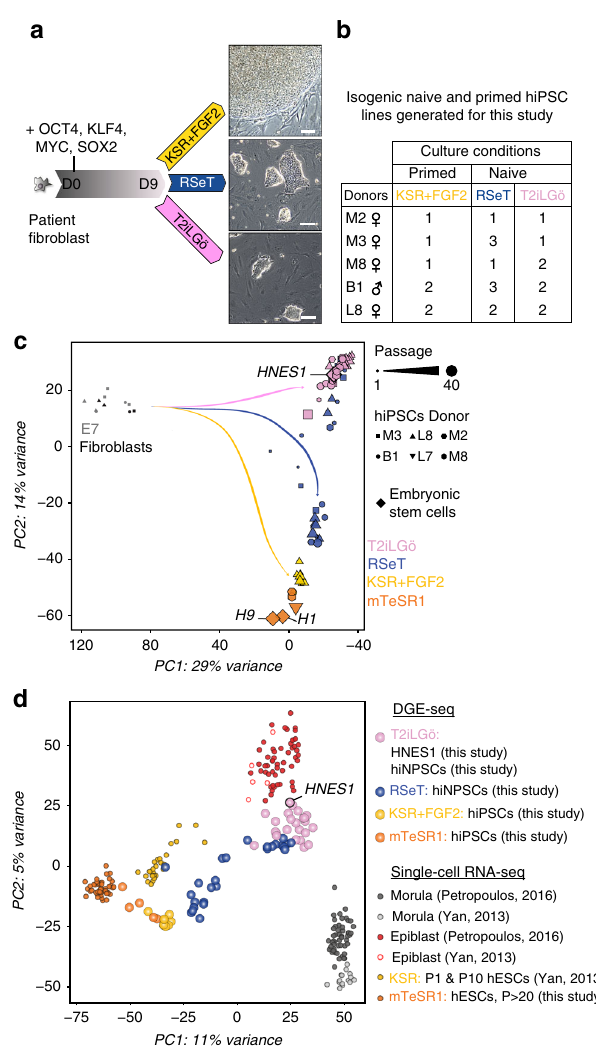
Fig. 1 Direct reprogramming of somatic cells into hiNPSCs. a Direct generation of isogenic naive and primed hiPSCs. Fibroblasts were transduced with 3 Sendai viruses expressing a polycistron KLF4/OCT4/ SOX2, MYC and KLF4 at a ratio of 5:5:3, respectively. Cells were split on feeders at day 7, and placed in the indicated media at day 9. Scale bar = 100 µ m. b Summary of lines generated for this study in primed (KSR+FGF2, yellow) or naive culture media (RSeT, blue or T2iLGö, pink) originated from 5 different donors. c Different pluripotent states are induced depending on culture media. Transcriptomes of hiPSCs and hiNPSCs, control primed hESC lines H1 and H9 or the naive hESC line HNES1 19 were analyzed by PCA. Symbols represent donor lines, and size of the symbols represents the passage. Arrows have been drawn to highlight the reprogramming trajectories. d T2iLGö hiNPSCs are the closest to human epiblast cells. PCA of single-cell RNA-seq data sets from preimplantation embryo samples 11,12 compared to primed hPSCs from ref. 11 and to primed/naive hiPSCs/hESCs from this